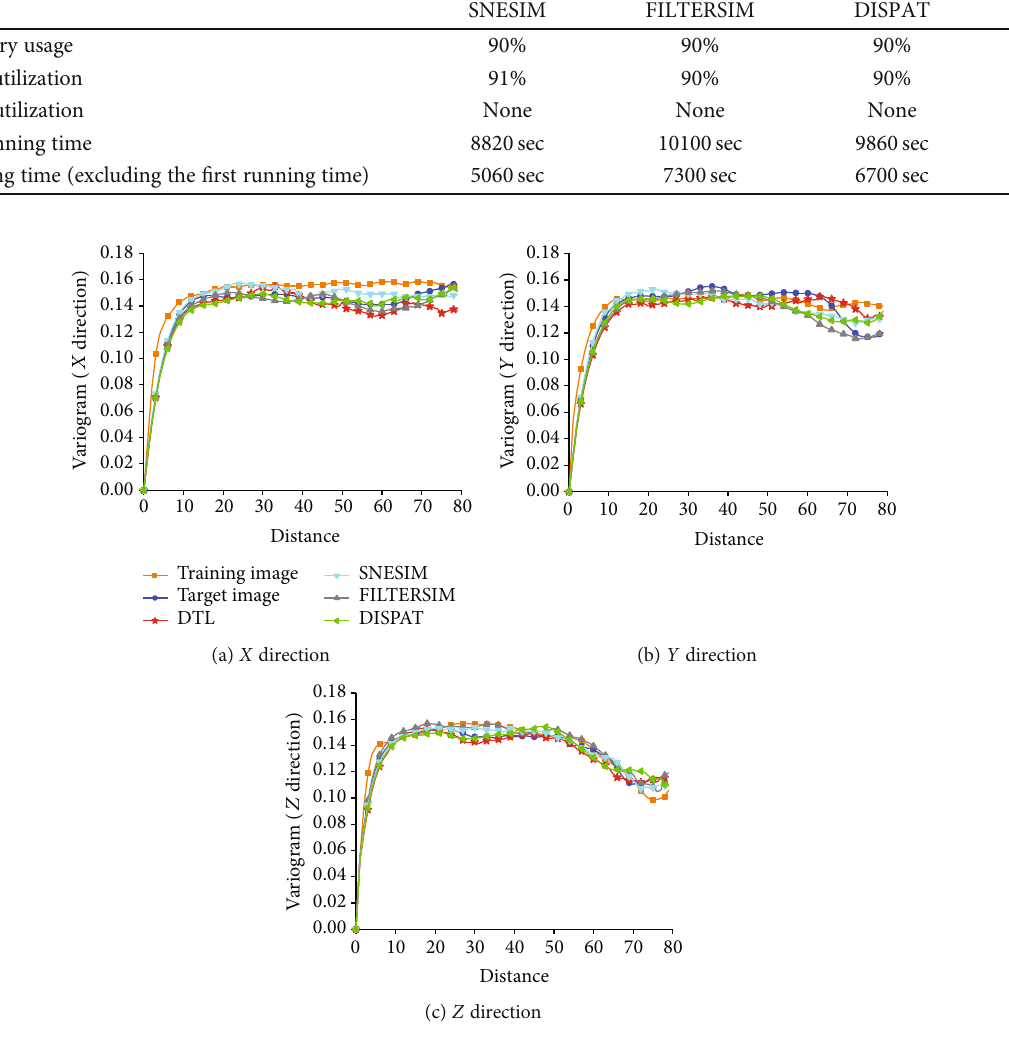
Figure 23: Variogram curves of reconstructed sandstone images by 5% conditioning data using SNESIM, FILTERSIM, DISPAT, and DTL in three